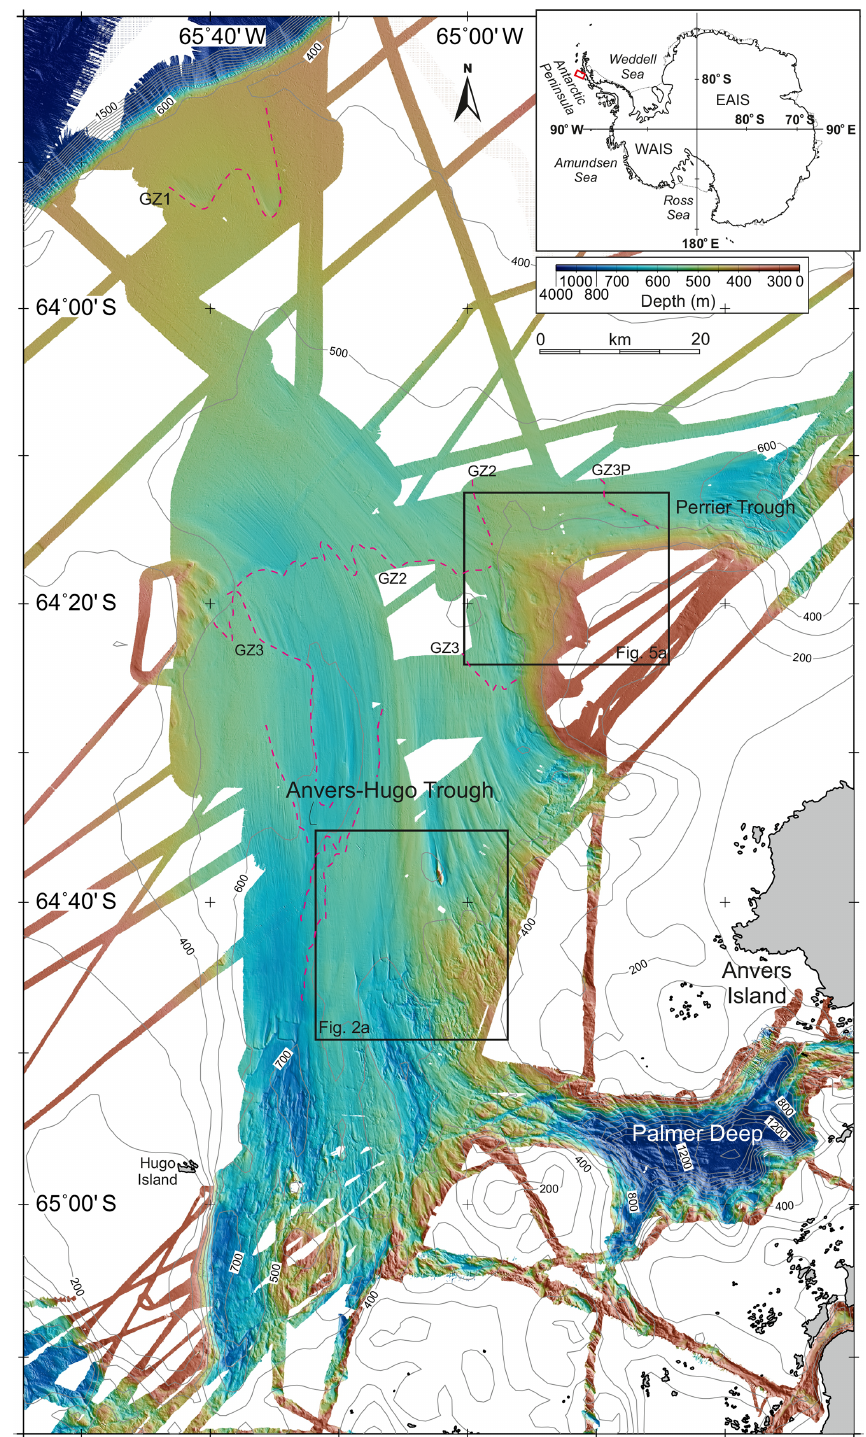
Figure 1. Multibeam bathymetry data over Anvers-Hugo Trough, Perrier Trough, and Palmer Deep. Grid-cell size 30m, displayed with shaded relief illumination from the northeast. Regional bathymetry contours from IBCSO v1.0 (Arndt et al., 2013). Red dashed lines mark interpreted past grounding zone positions, with the earliest ones labelled GZ1–GZ3. The grounding zone furthest upstream in Perrier Trough is labelled GZ3P, as it did not necessarily form synchronously with GZ3. Only discontinuous segments of later grounding zone positions are identified in Anvers-Hugo Trough. Black boxes show locations of Figs. 2a and 5a. The red box in the inset shows the location of the main figure. EAIS, East Antarctic Ice Sheet; WAIS, West Antarctic Ice